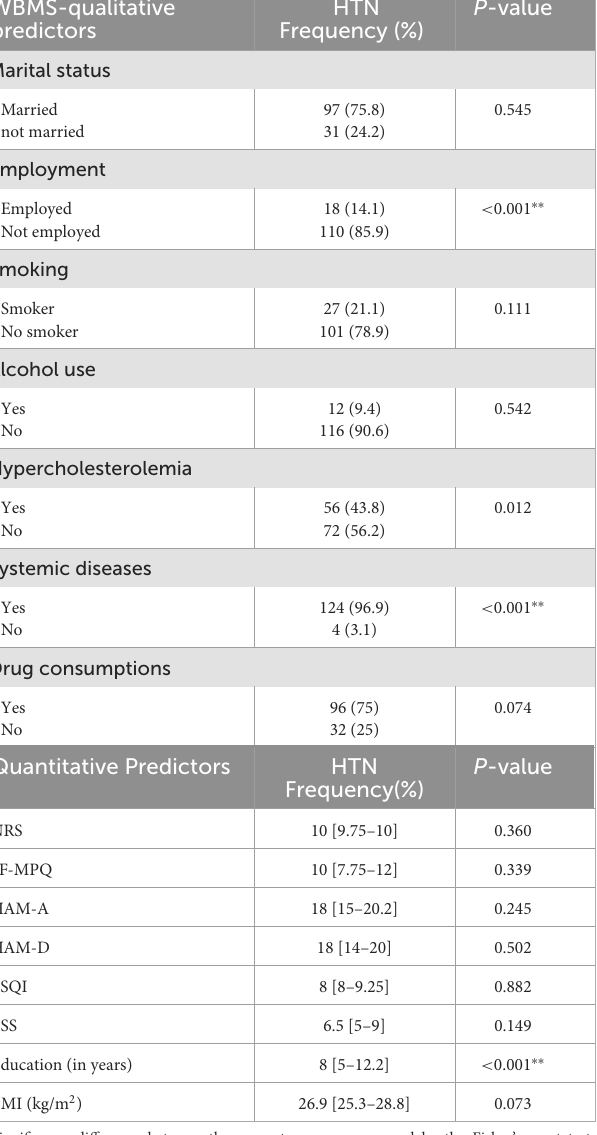
TABLE 6 Dependence analysis among 122 HW with HTN and qualitative and quantitative predictors. HWC- Qualitative